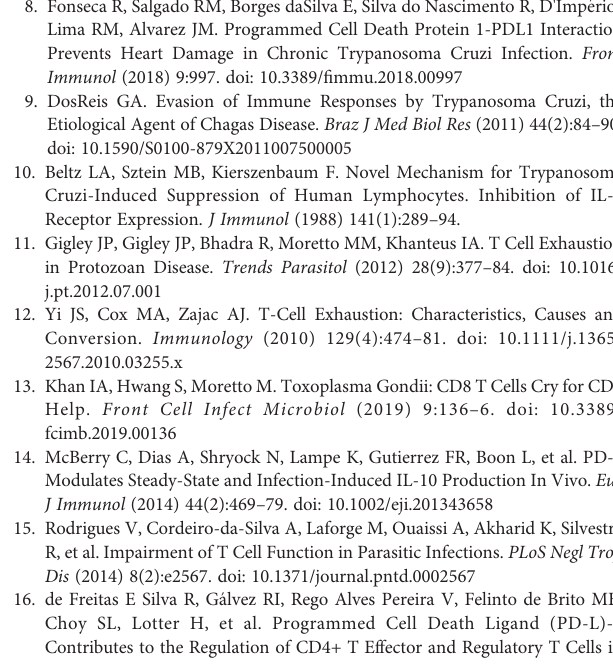
Supplementary Figure 1 | (A) Experimental set-up for the infection of BMDCs in vitro. (B) Flow cytometry gating strategy for BMDCs. Supplementary Figure 2 | (A) Flow cytometry Gating strategy and exemplary dot plots for PD-L1 expression in vivo on CD11c + CD11b - cells (DCs) and CD11b + Ly6G - Ly6C + cells (M F ) at day 15 post-infection. (B) Expression of PD-L2 on CD11c + CD11b - (DCs) and, Ly6G-Ly6C+CD11b+ (M F ). Data are a compilation of two independent experiments (n.i. = 4; infected=6). Data were analyzed for statistical signi fi cance using the Kruskal-Wallis test following Dunn´s multiple comparisons test. Asterisks denote P values as described in Methods; ns (not signi fi cant) were not plotted to avoid busy fi gures. Supplementary Figure 3 | (A) Gating Strategy and exemplary dot blots for co- inhibitory receptors expression on CD4 + and CD8 + T cells from n.i. and infected WT and PD-L1 KO mice. (B) PD-1 on CD4 + T cells (C) PD-1 on CD8 + T cells. (D) Tim-3 on CD4 + T cells (E) Tim-3 on CD8 + T cells. (F) CD244 on CD4 + T cells (C) . CD244 on CD8 + T cells Supplementary Figure 4 | (A) Parasitemia and (B) Bodyweight curves incl. the absolute number of WT and PDL1 KO mice used per timepoint. Data are from three independentexperiments. Valuesare givenasmeans±standarderrorofthe means (SEM). (C) Tim-3 induction is T. cruzi strain independent since it is signi fi cantly higher also after infection with the T. cruzi Brazil strain, which leads to chronic infections in